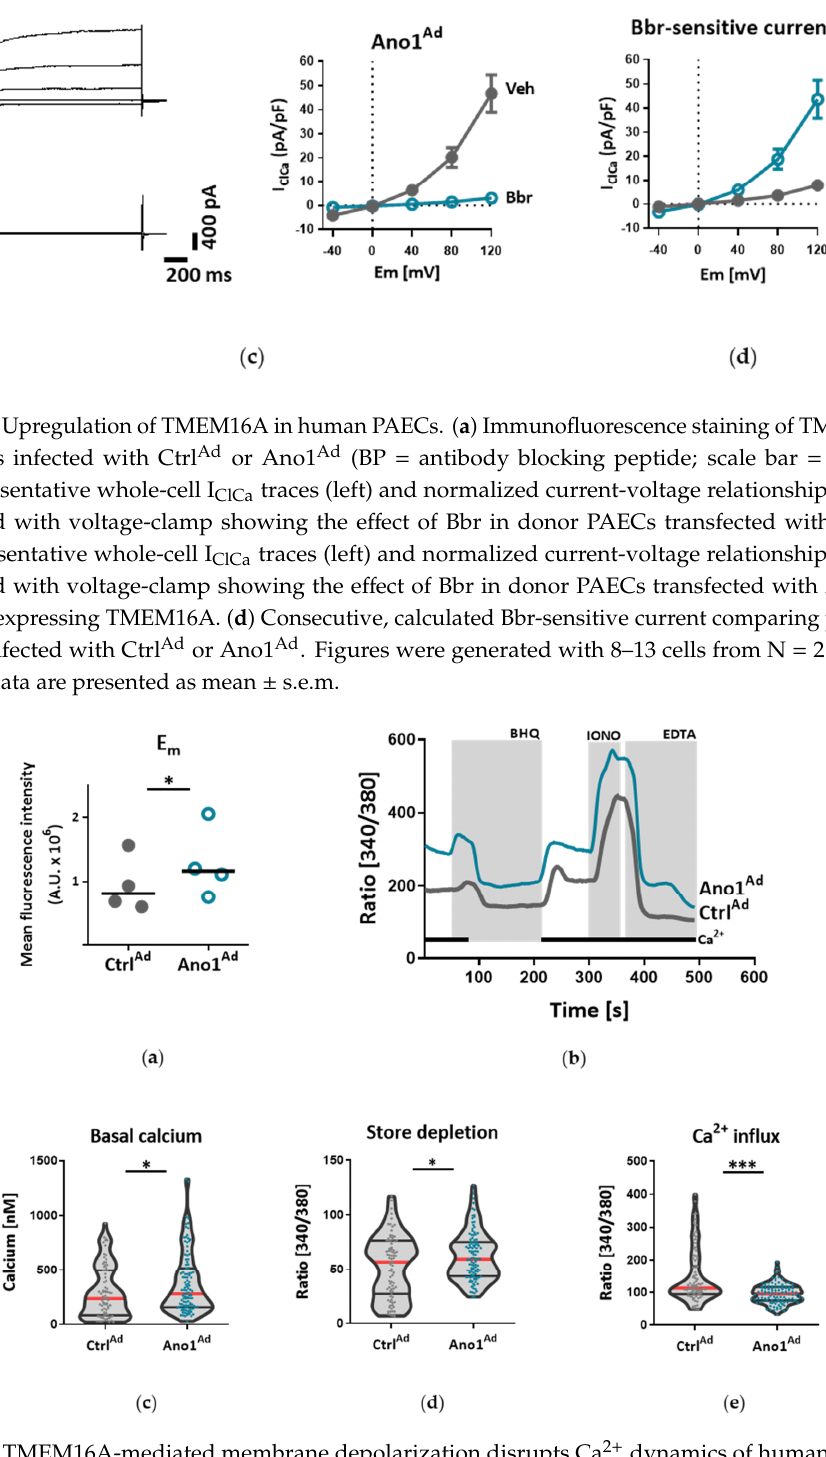
Figure 4. TMEM16A-mediated membrane depolarization disrupts Ca 2 + dynamics of human PAECs. ( a ) Fluorometric measurements indicating shift in relative resting membrane potential (E m ) of donor PAECs infected with Ctrl Ad or Ano1 Ad using DiBAC 4 (3) dye. ( b ) Representative traces depict changes in intracellular Ca 2 + detected in PAECs transfected with Ctrl Ad or Ano1 Ad . ( c – e ) The e ff ect of TMEM16A overexpression on cytosolic baseline Ca 2 + concentration ([Ca 2 + ] i ), store depletion and Ca 2 + influx using Fura-2 in donor PAECs infected with Ctrl Ad or Ano1 Ad (BHQ = butylhydroquinone). Figures were generated with 80-116 cells from N = 3 healthy donors. * p < 0.05, *** p < 0.001, paired ( a ) and unpaired t-tests ( c – e